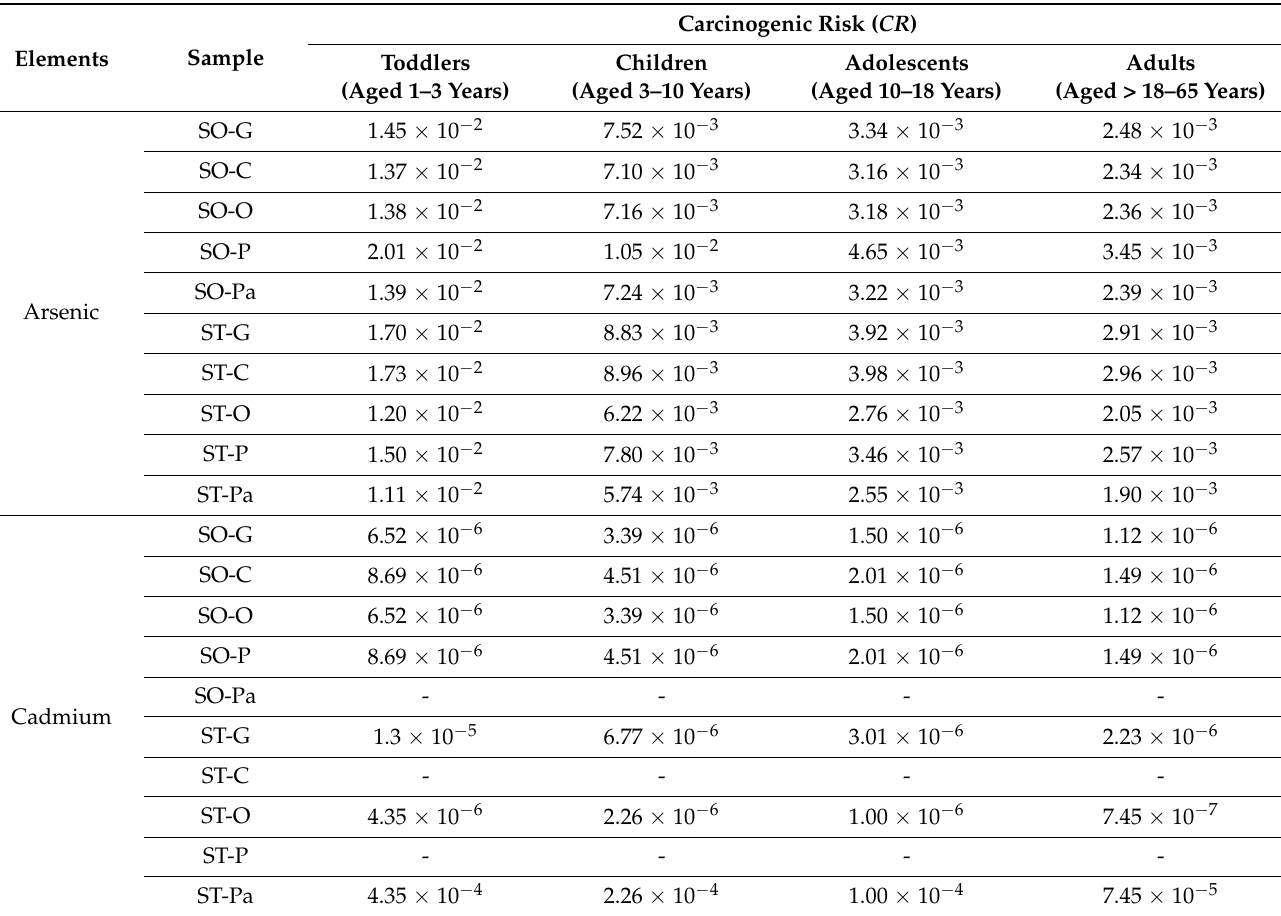
Figure 2. Risk quotient ( HQ ) and hazard index ( HI ) due to the consumption of canned sardines sold in Brazil for individuals aged 2, 5, 14, and 30 years. Table 5. Values of carcinogenic risk ( CR ) for exposure to As, Cd, Cr, Pb at ages 2, 5, 14, and 30 years in canned sardines SO, ST of the companies G, C, O, P, and Pa, considering an intake of 84